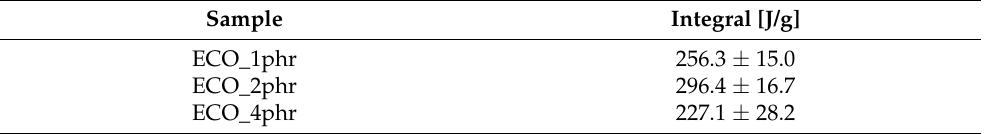
Figure 2. Heat released during UV-light irradiation of ECO as a function of time at varying concen- tration of photo-initiator. THS photo-initiator was added in 1, 2, and 4 phr. The light intensity was set as 130 W/cm 2 . Table 1. Heat released during photo-DSC analysis with different amount of photo-initiator.